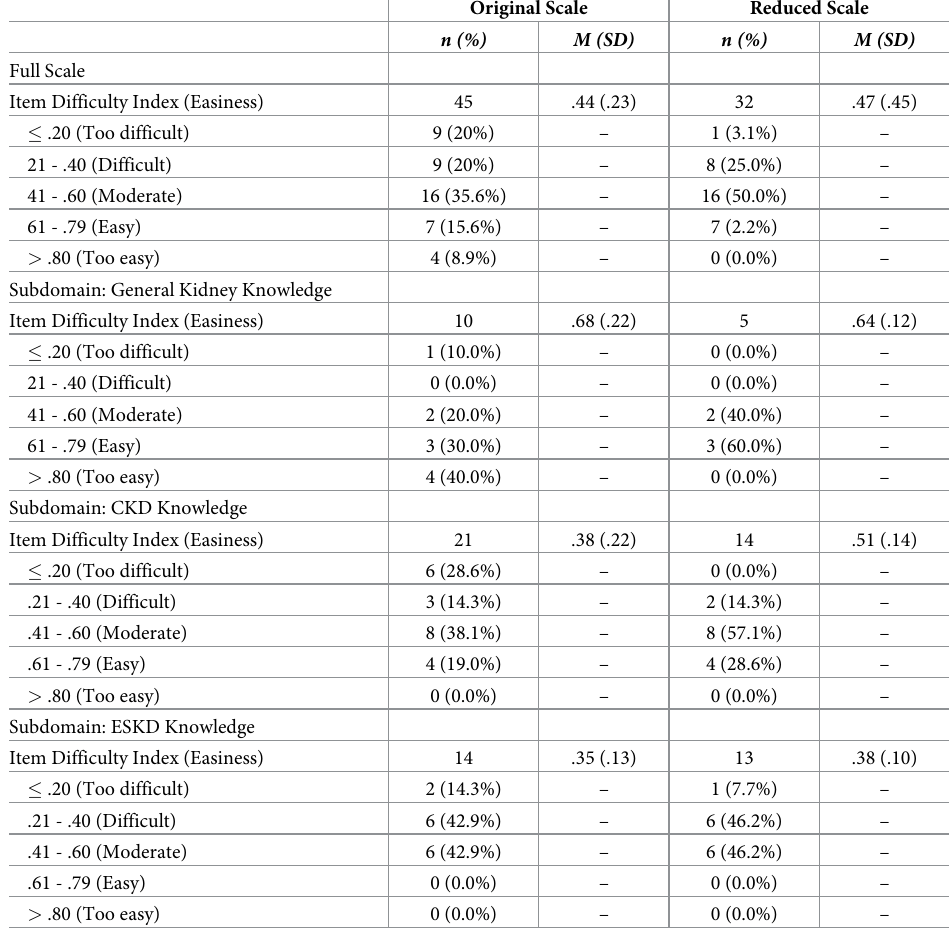
Table 2. Item difficulty